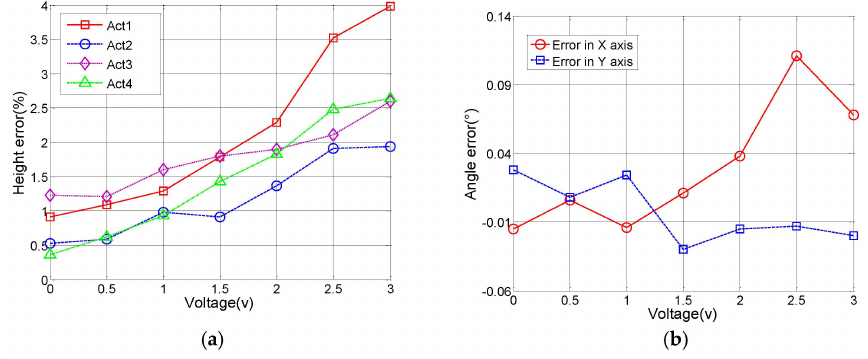
Figure 7. ( a ) The height difference between the model prediction and experimental data (from Figure 6); ( b ) The corresponding tilt angle error of the mirror